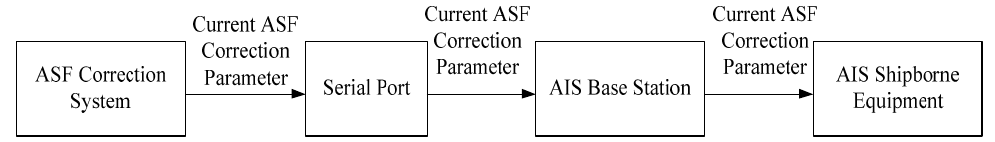
Figure 16. The schematic diagram of the signal connection between the ASF correction system and the AIS positioning system.